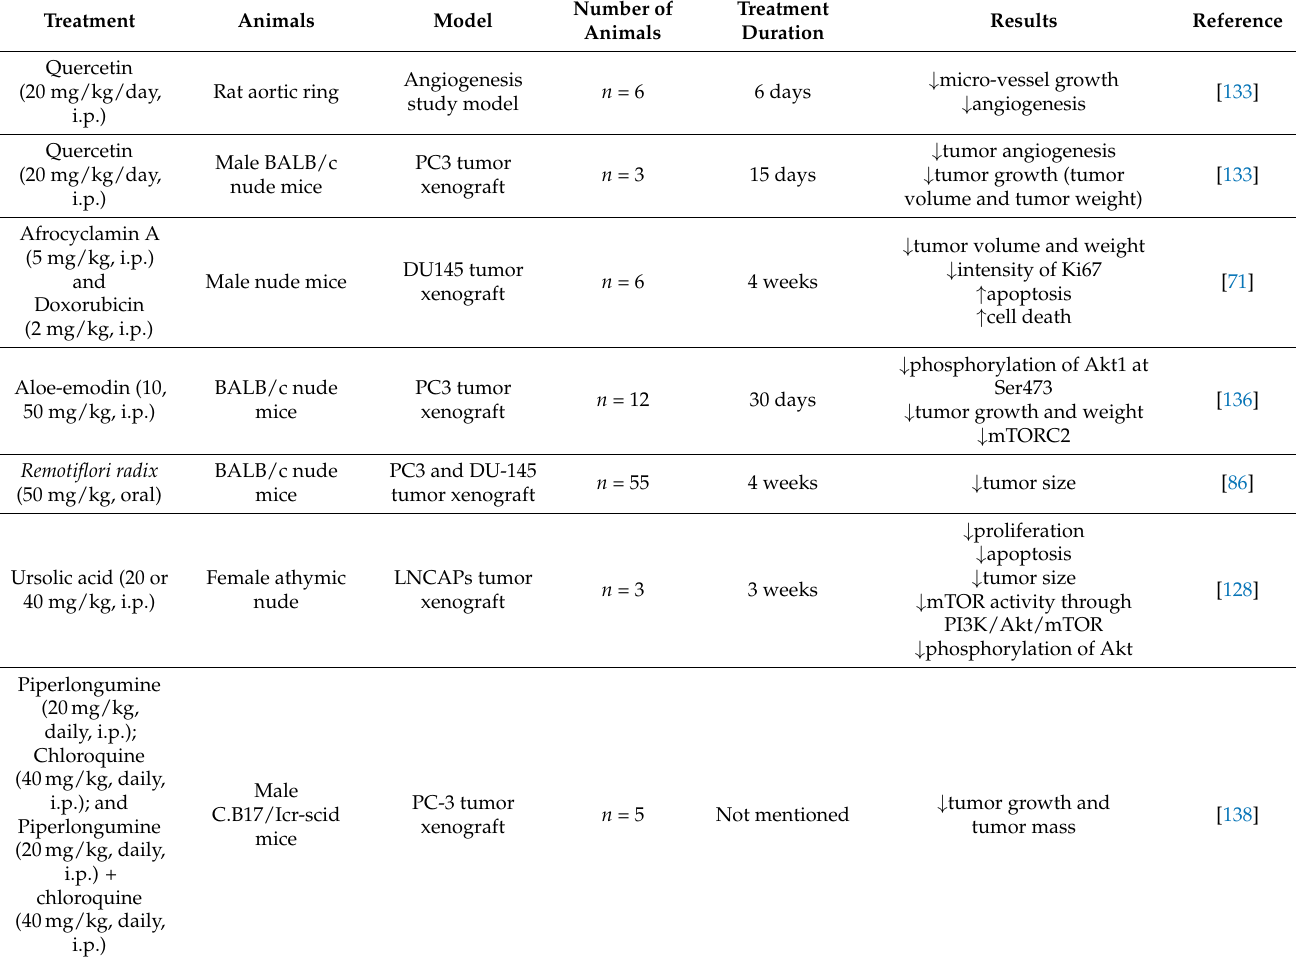
Table 5. In vivo studies on natural PI3K/Akt/mTOR inhibitors in prostate